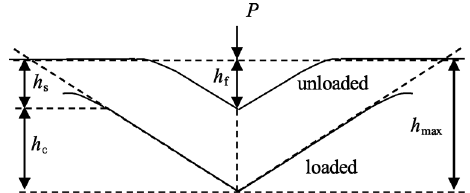
Fig. 4 Schematic illustration of parameters describing the contact of the indenter with the sample at loaded and unloaded state according to Ref.